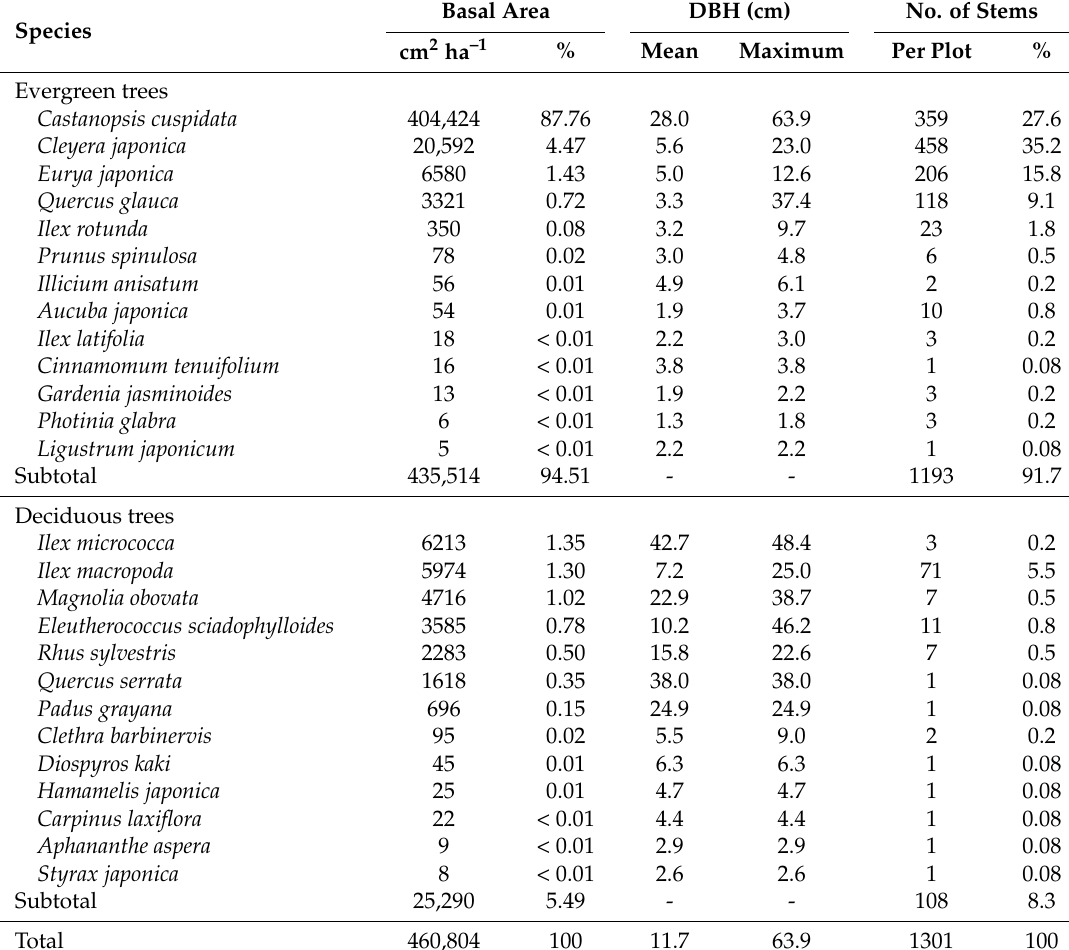
Table 1. Species composition of trees (stems ≥ 1.3 m of height) in the permanent plot (0.7 ha) in January 2017, DBH: Diameter at breast